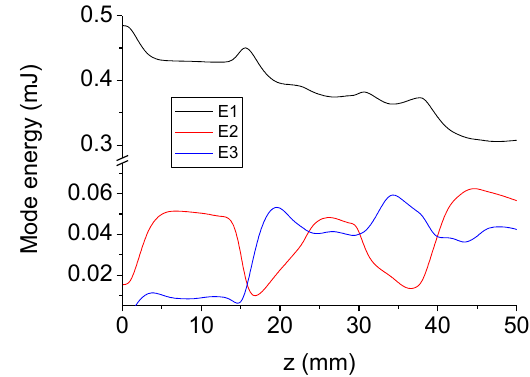
Fig.2 The energies contained in the first three modes